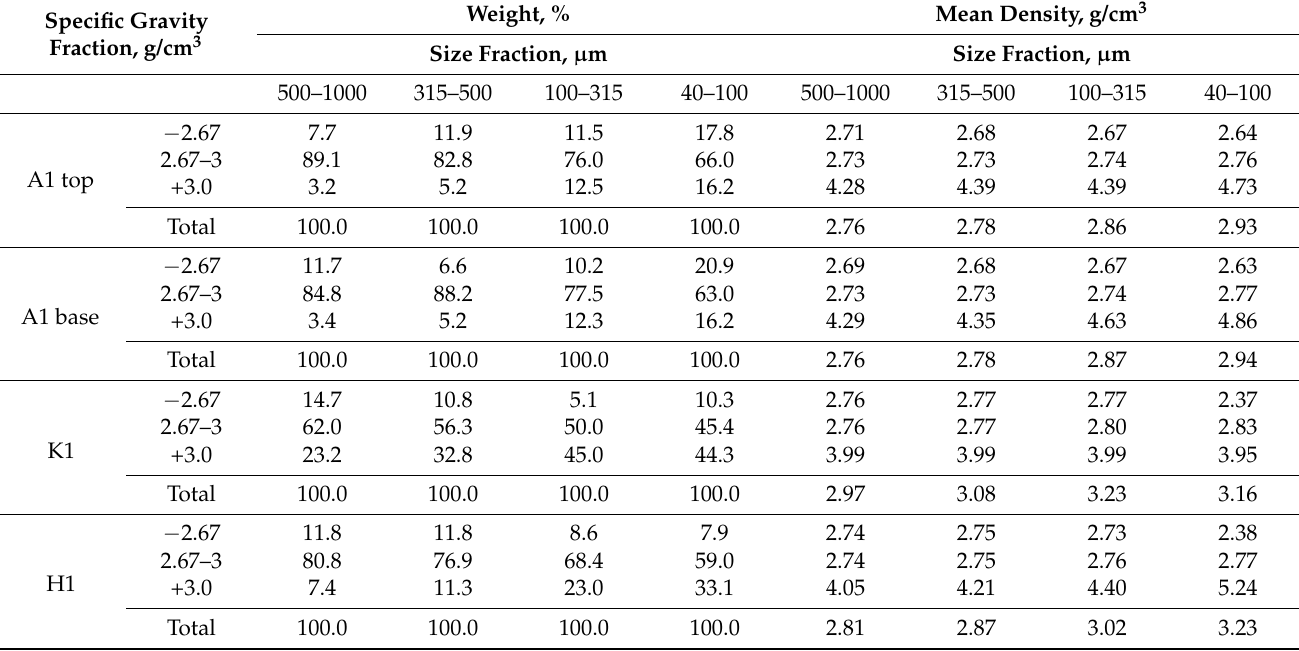
Table 6. Sink–float analysis results of all four waste rock dump